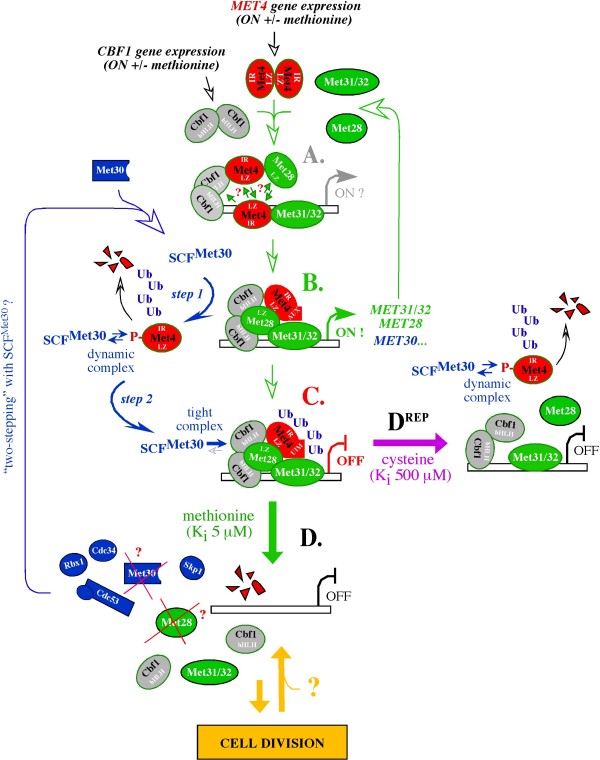
The emerging molecular mechanism of Met4 regulation by SCFMet30. The mechanism of Met4 activation by SCFMet30 is based on the prediction that the formation of Met4 homodimers antagonizes proper assembly between Met4 and cofactors (A), and that the dissociation of Met4 homodimers by SCFMet30 (B, step 1) is necessary to stabilize and/or rearrange the protein-protein interactions within the Met4/Met28/Cbf1 complex, triggering its proper assembly (B). The low abundance of SCFMet30 suggests that proteolysis of the remaining Met4 molecule occupying SCFMet30 (B, step 1) is necessary for SCFMet30 recycling (B, step 2). As a result, 'two stepping' with SCFMet30" could be necessary for each round of Met4 activity at a promoter (all steps involving SCFMet30 are marked in blue). The stabilizing effect of cofactors on the SCFMet30-Met4 interaction ('tight complex', note exposure of the UIM domain in Met4) allows Met4 inhibition by polyubiquitination only (C), unless methionine (D) or cysteine (DREP) is available to destabilize the tight interaction between Met4 and SCFMet30, allowing Met4 proteolysis. Disassembly of the Met4 complex by the proteasome could link activation of methionine biosynthesis to cell division by releasing the DNA binding cofactors Cbf1 and Met31/32 from promoters (D), which, at least in the case of Cbf1, would make it available for its cell division role. Dissociation of Met4 prior to its proteolysis could protect the cofactors and SCFMet30 from effects of the proteasome-mediated disassembly (DREP), preventing Cbf1 and/or Met31/32 release. See text for details.